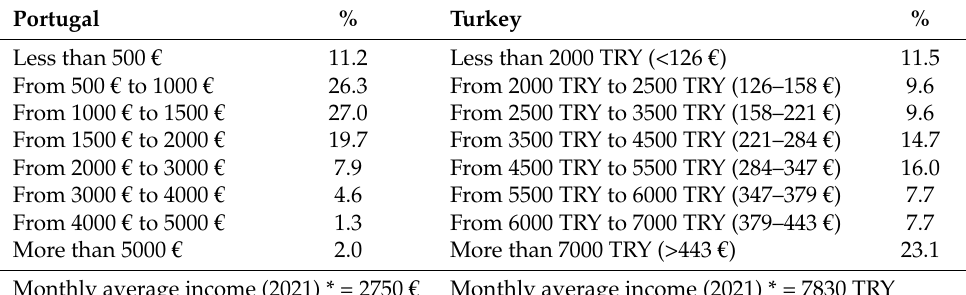
Table 5. Monthly household income of the